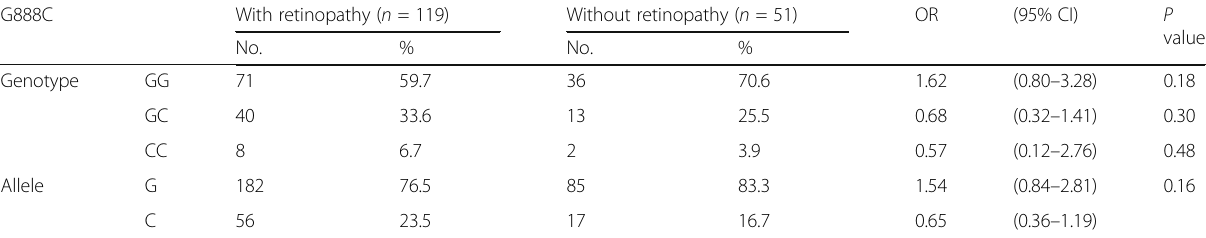
Table 4 Distribution of genotype and alleles, and frequency of G-888C polymorphism of SDH gene in patients with and without DR G888C